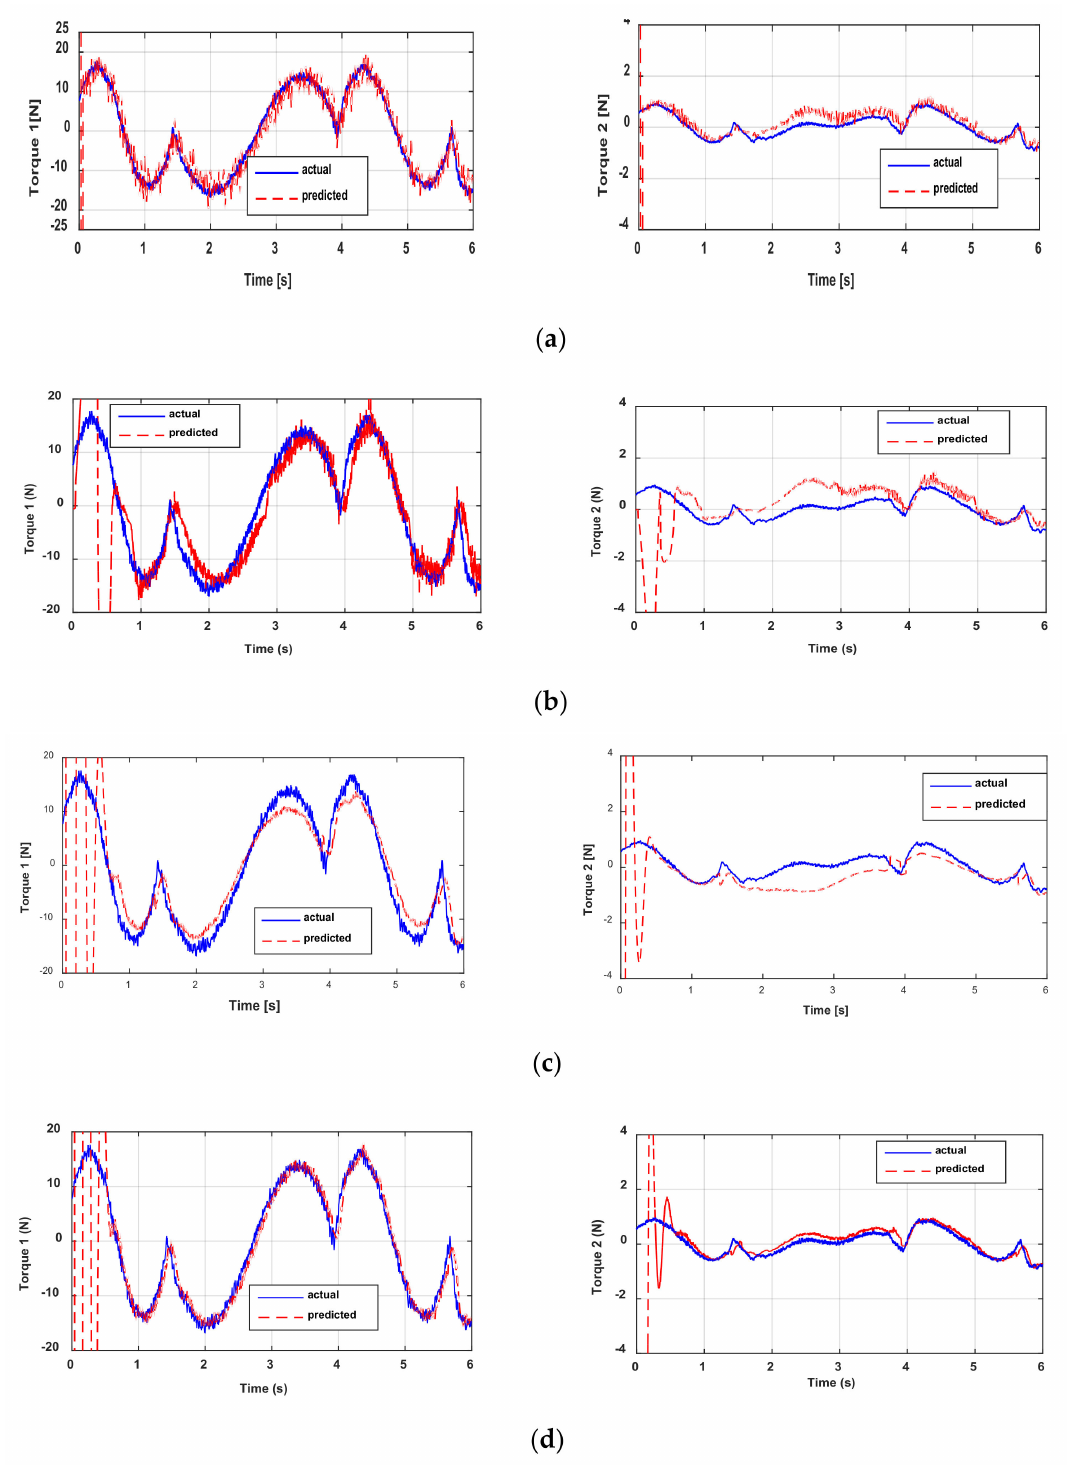
Figure 8. Actual and predicted torques: cross-validation through ( a ) ED+FIR, ( b ) the 2SMD algorithm, ( c ) the ASTD algorithm, and ( d ) the P2SMD